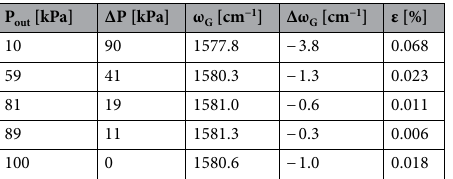
Table 1. Summary of the estimated strain values at various P out for DEVICE